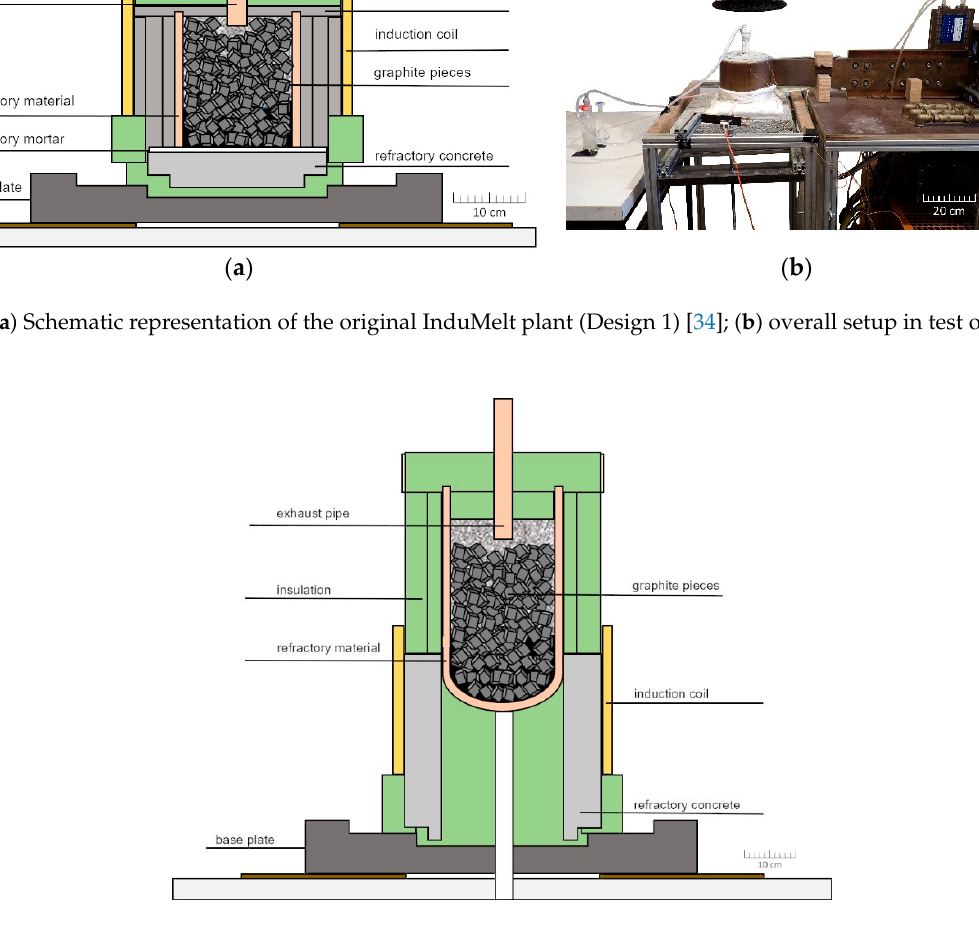
Figure 4. Schematic representation of the new reactor design (Design 2).